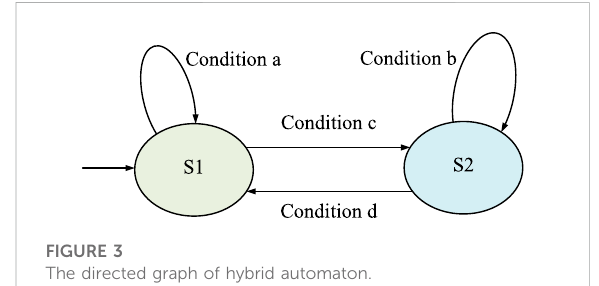
FIGURE 3 The directed graph of hybrid automaton.